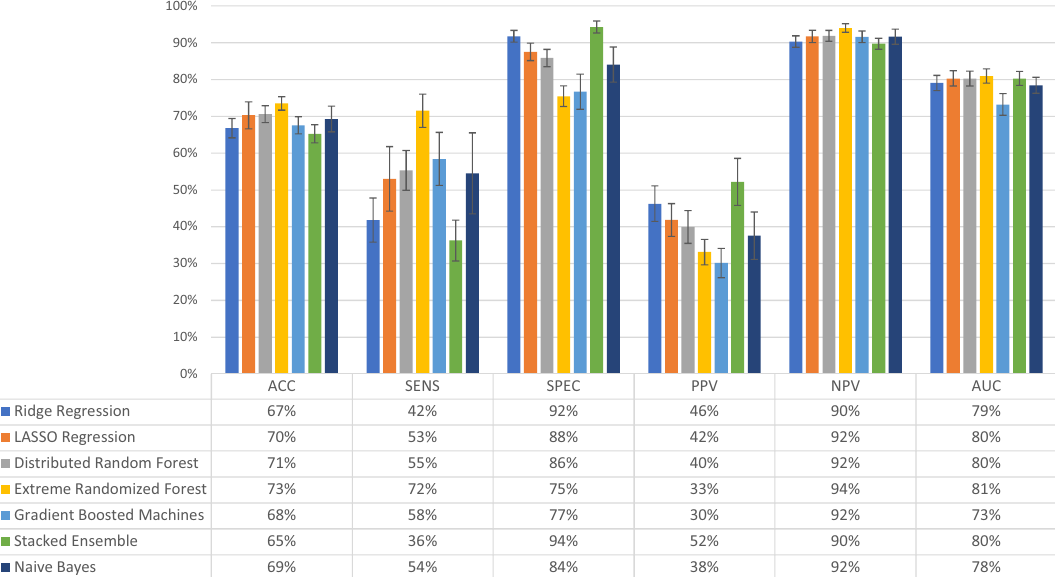
Figure 2. Evaluation of model performance in the total combined dataset (n = 2385 women). The combined dataset contained the background, medical and pregnancy-related variables, as well as answers to the questionnaires Resilience-14, Sense of Coherence-29 and Vulnerable Personality Scale Questionnaire. The models tested were Ridge Regression, LASSO Regression, Distributed Random Forest, Extremely Randomized Trees, Gradient Boosted Machines, Stacked Ensemble, and Naïve Bayes. Models were assessed for accuracy (ACC), sensitivity (SENS), specificity (SPEC), positive predictive value (PPV), negative predictive value (NPV), and area under the curve (AUC), the outcome being depressive symptoms at 6 weeks postpartum. The bars represent the level of performance measures (in percent) and the table below the bar plot presents the exact numerical values. Error bars represent one standard deviation from the mean.